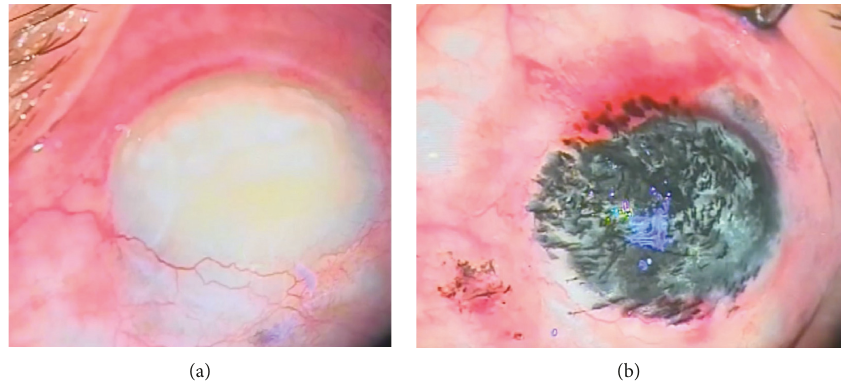
Figure 2: (a) Preoperative total corneal opacity and (b) Postoperative photo after corneal tattooing.